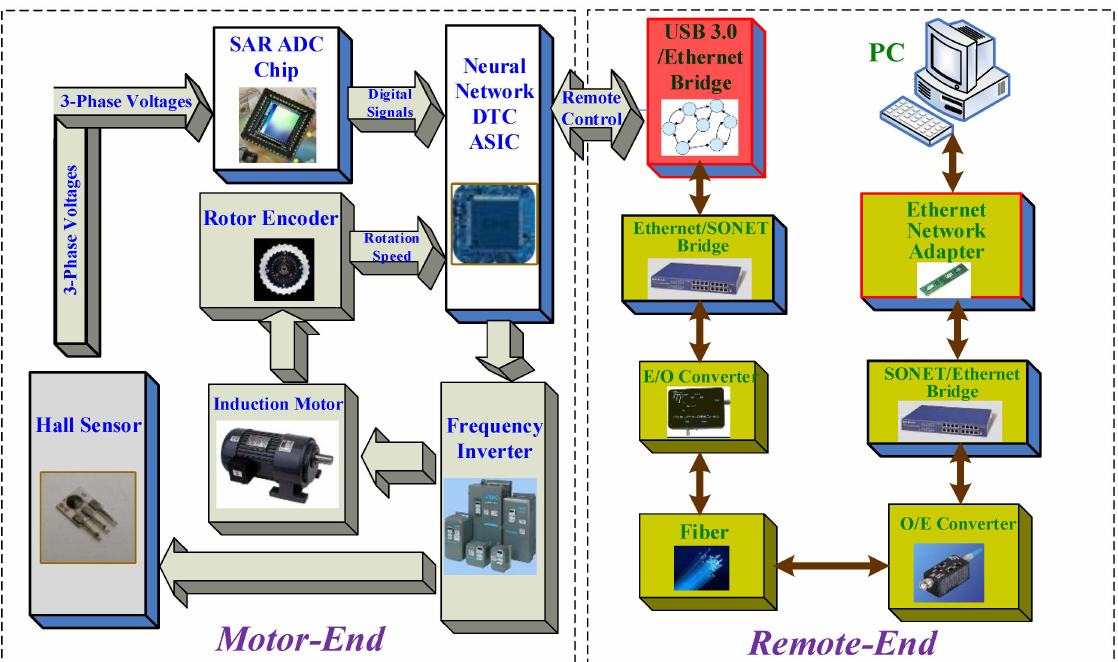
Figure 1. A neural network direct torque control (NNDTC) architecture for AC induction motor.